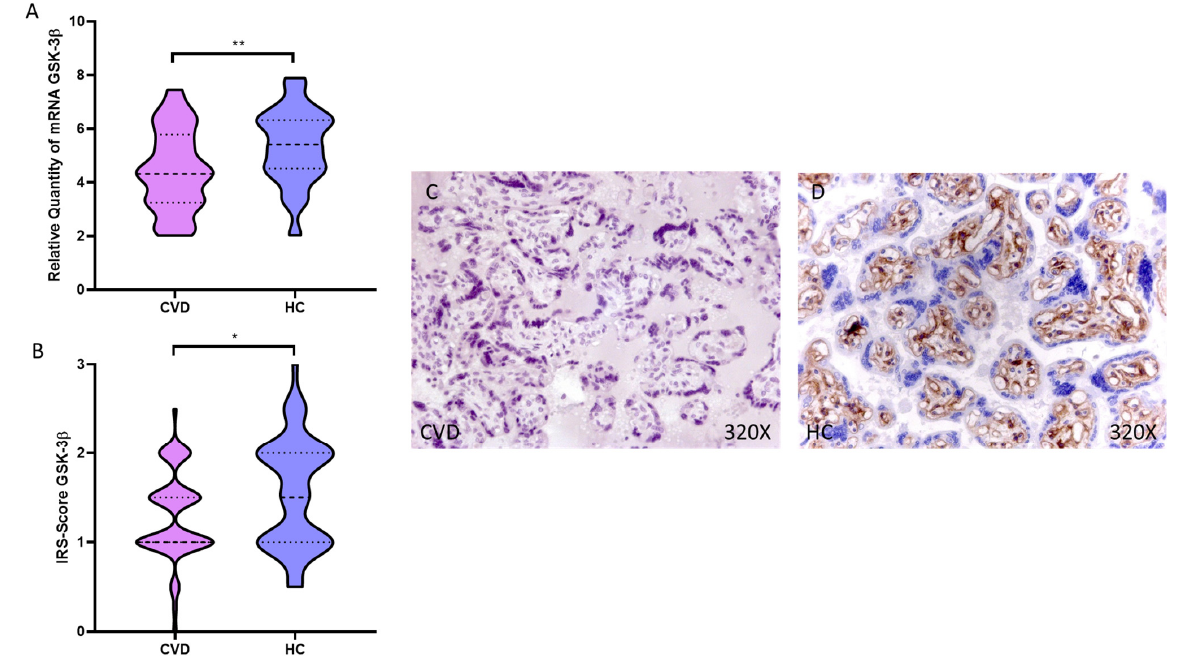
Figure 4. ( A ). GSK-3 β mRNA expression in the CVD patients (chronic venous disease) and HC group (Healthy controls). ( B ). IRS-Scores for GSK-3 β in the placenta villi of the CVD group and the HV group. ( C , D ). Images showing the immunostaining for GSK-3 β in the placenta villi of the CVD group and the HV group. p < 0.05 (*), p < 0.01